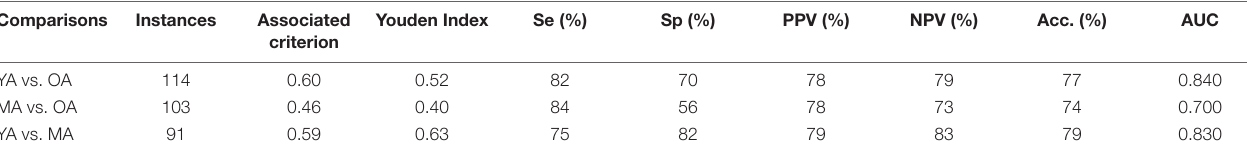
FIGURE 3 | Convolutional Neural Network analysis. Receiver operating characteristic (ROC) curves were calculated to differentiate YA, MA, and OA. (A) YA vs. OA (green line). (B) MA vs. OA (blue line). (C) YA vs. MA (orange line). (D) Comparison of the ROC curves. The dashed red line represents the performance of a random classifier. TABLE 2 | Performance of the CNN algorithm in classifying handwriting samples collected from the whole group of healthy